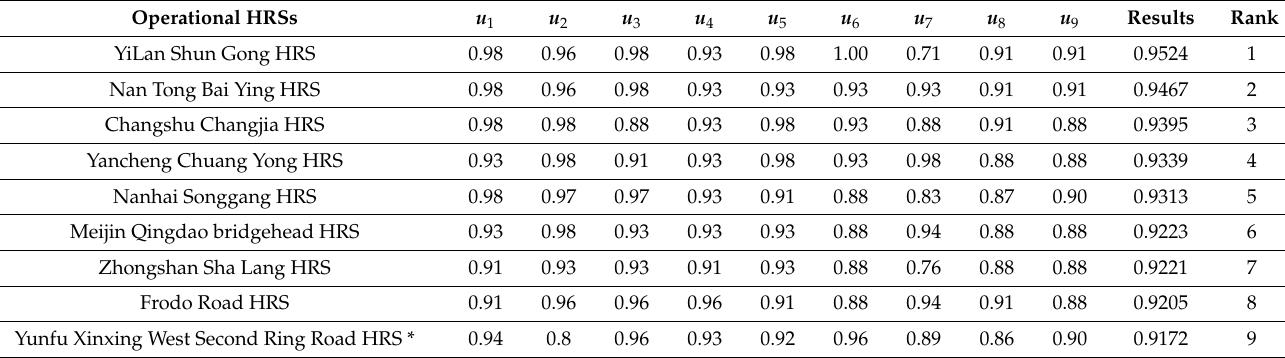
Table A1. Evaluation results of indices and ranking of 50 operational HRSs in